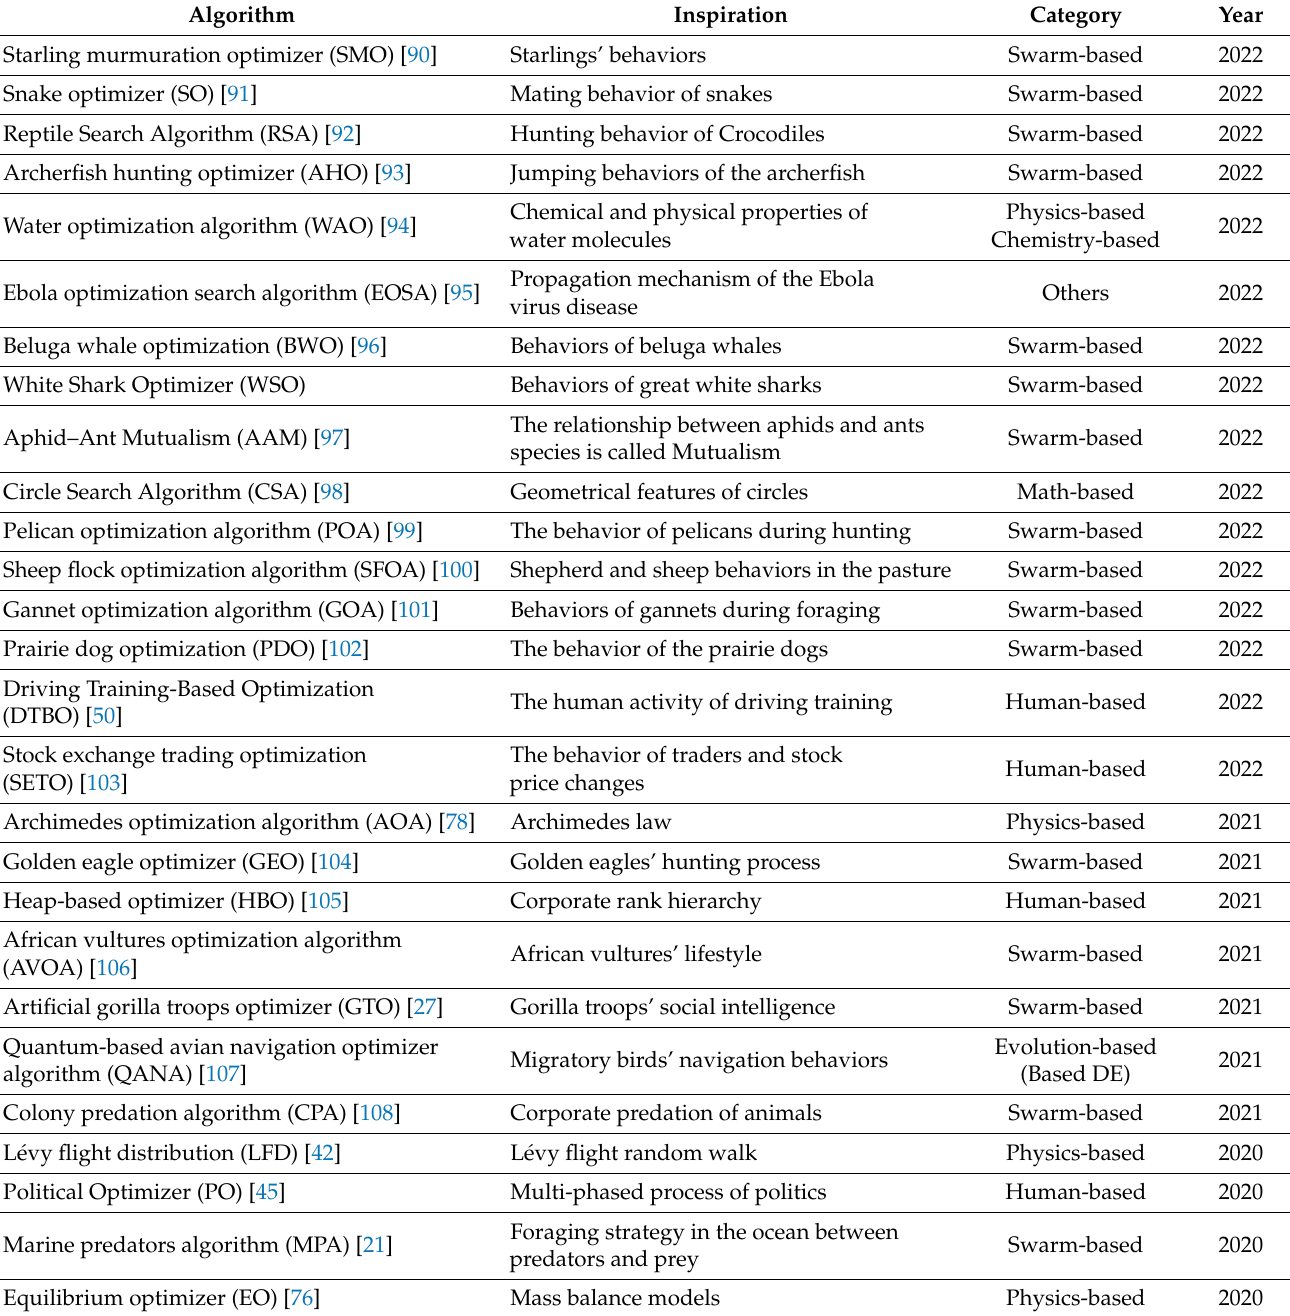
Table 1. Classification and inspiration of some recently-published metaheuristic